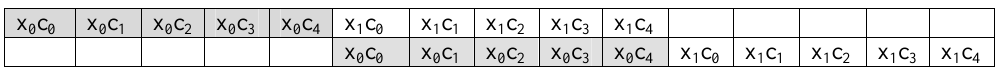
Figure 10: Self-similarity of PN code Modulated Traffic